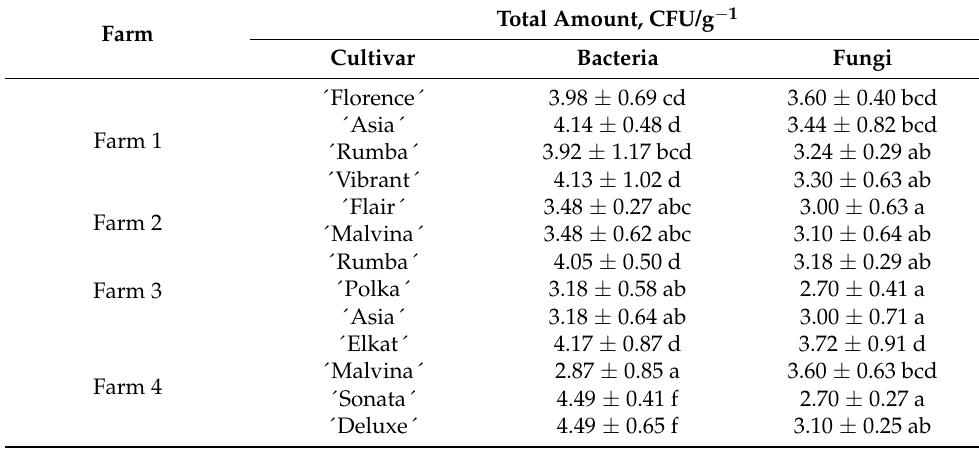
Table 5. The total amount of colony-forming units (CFU g − 1 ) in strawberry soil from different farms. Means followed by the same letter did not differ significantly ( p <